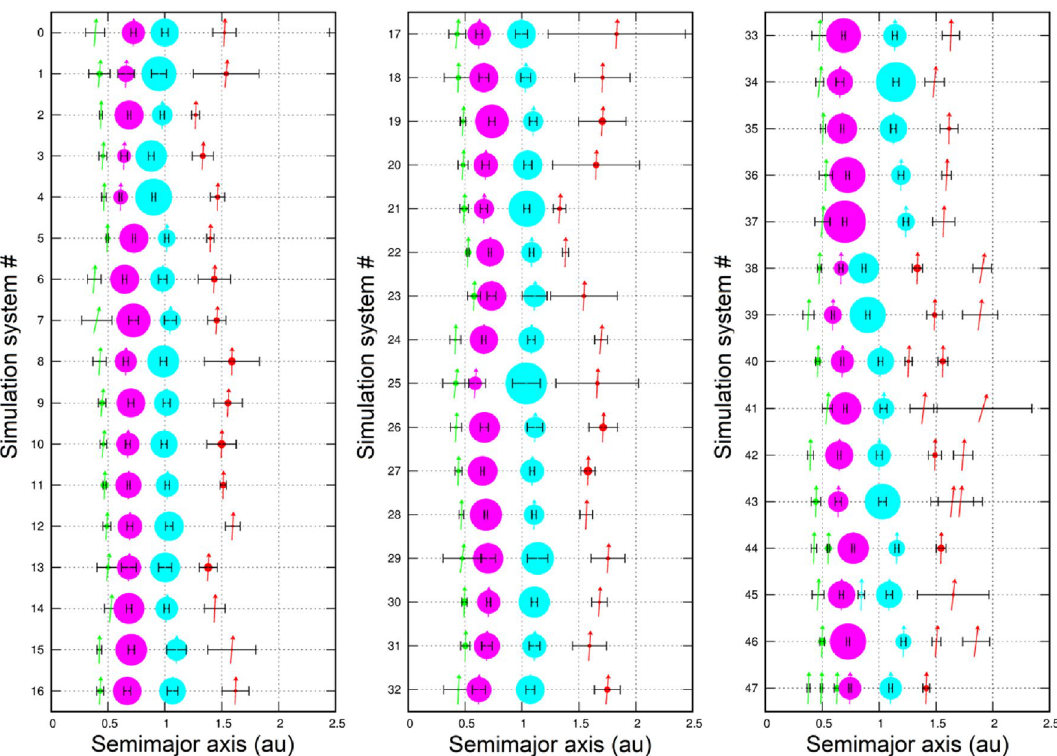
Figure 2. Comparison of 47 individual analogue systems containing representative planet analogues of each terrestrial planet with the solar system planets (system #0). Planet analogues of Mercury, Venus, Earth and Mars are indicated by green-, magenta-, cyan- and red-filled symbols, respectively. The inclination i of the planets is represented by the angle between the vector and the perpendicular (e.g., the vector points to the top for i = 0°). The error bars indicate the variation in heliocentric distance based on the object’s perihelion and aphelion. The radii of planet symbols scale in proportion to